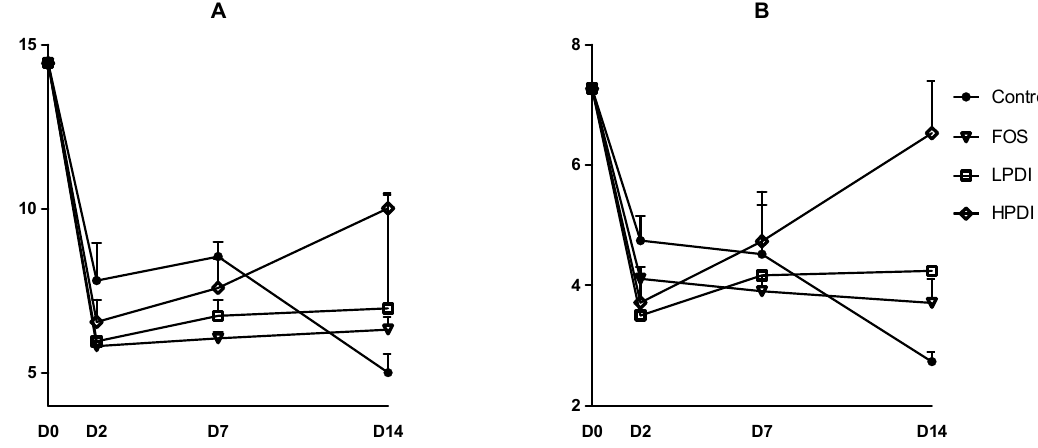
Figure 2. Alpha-diversity at the genus level as per ( A ) the exponential Shannon index (Hill number 1); and ( B ) the inverse Simpson index (Hill number 2).